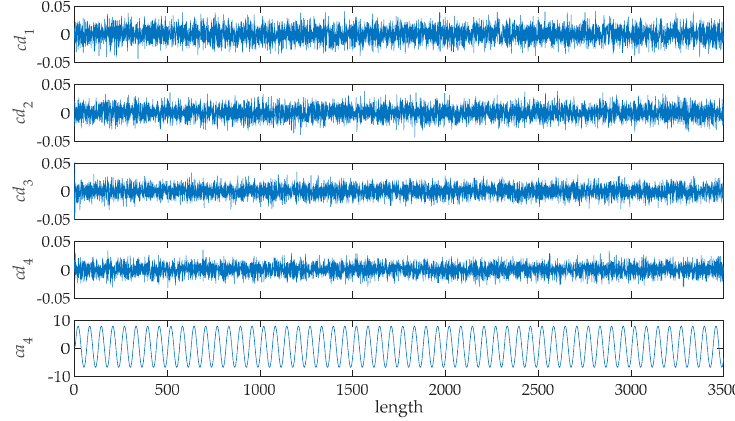
Table 1. Harmonics in signals.